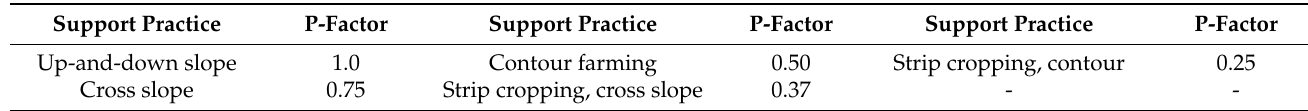
Table 9. Conservation practice (P-Factor)